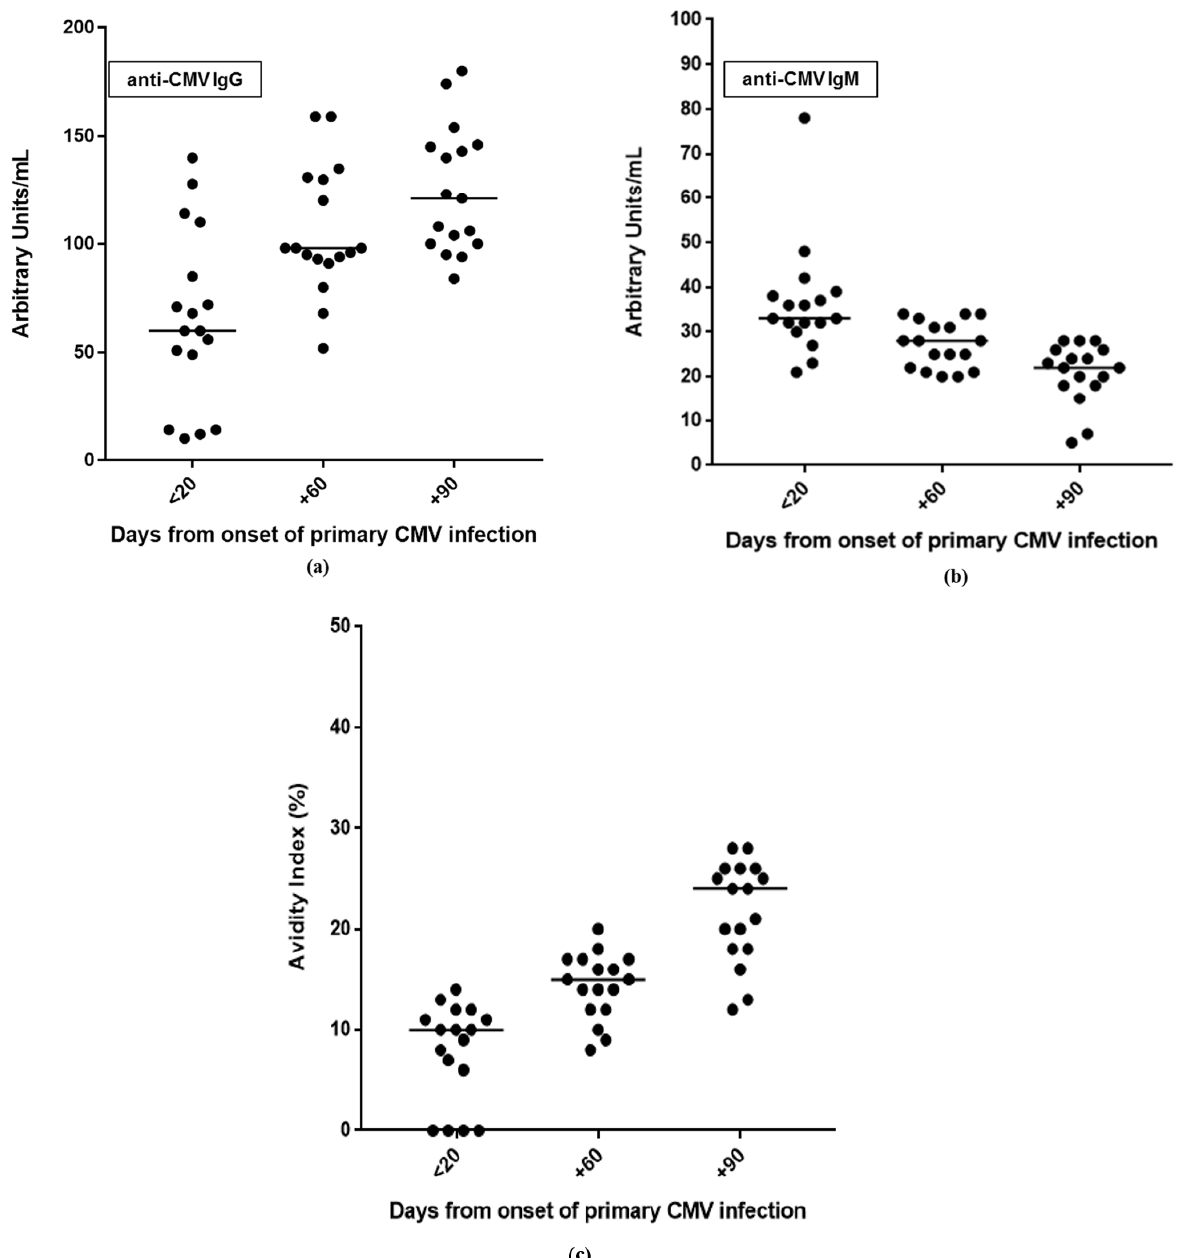
Figure 1. Kinetics of antibody responses during the three-month follow-up after primary CMV infection: ( a ) anti-CMV IgG and ( b ) IgM in serum samples; ( c ) IgG avidity index.